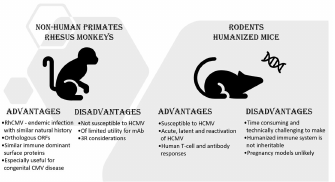
Figure 1. Animal models for CMV infection and